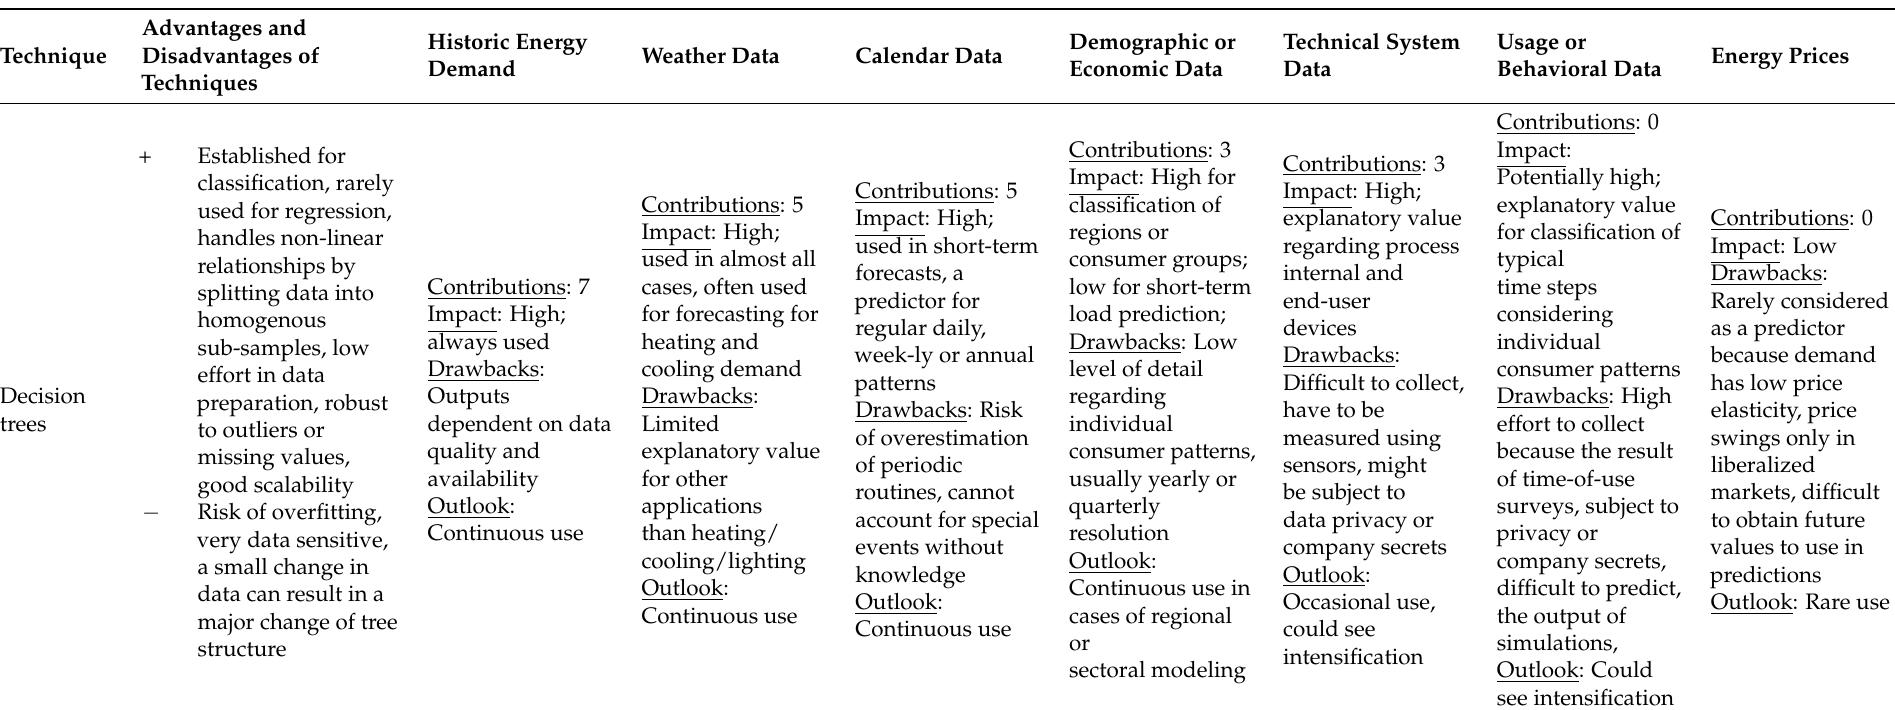
Table 6. Techniques and input data used (3/5). Continuation of Table